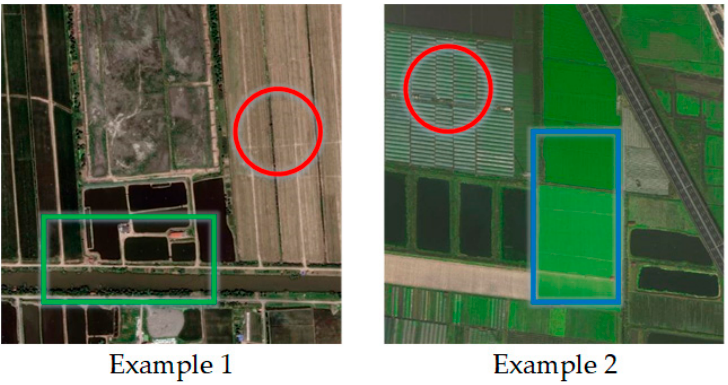
Figure 1. Illustration of specific characteristics in coastal remote sensing images.